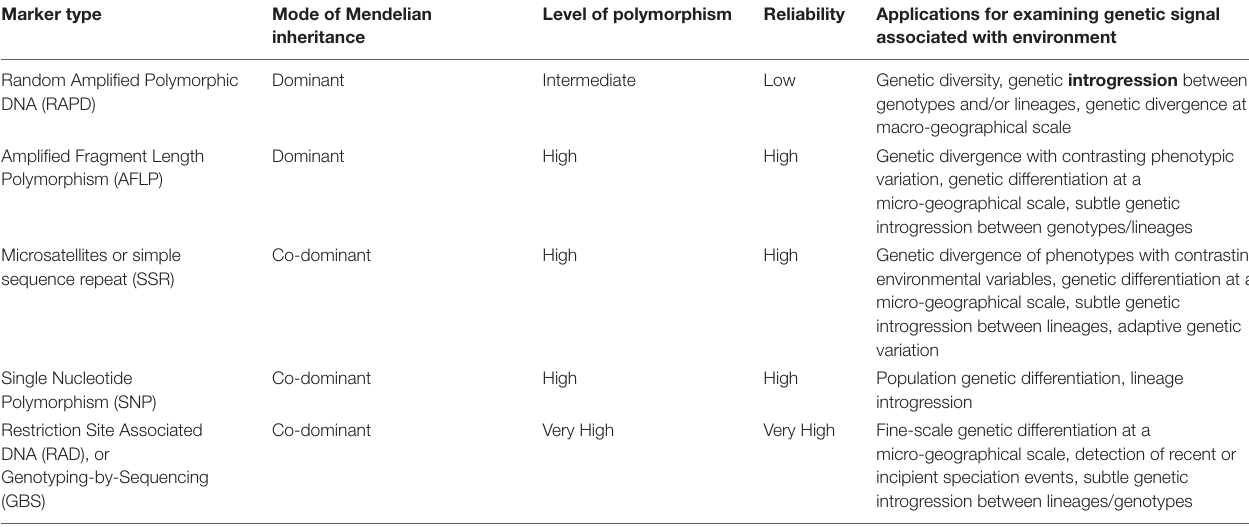
TABLE 1 | A brief description of modern molecular techniques used to examine different levels of genetic variation in the context of the interaction of environment and genotype.